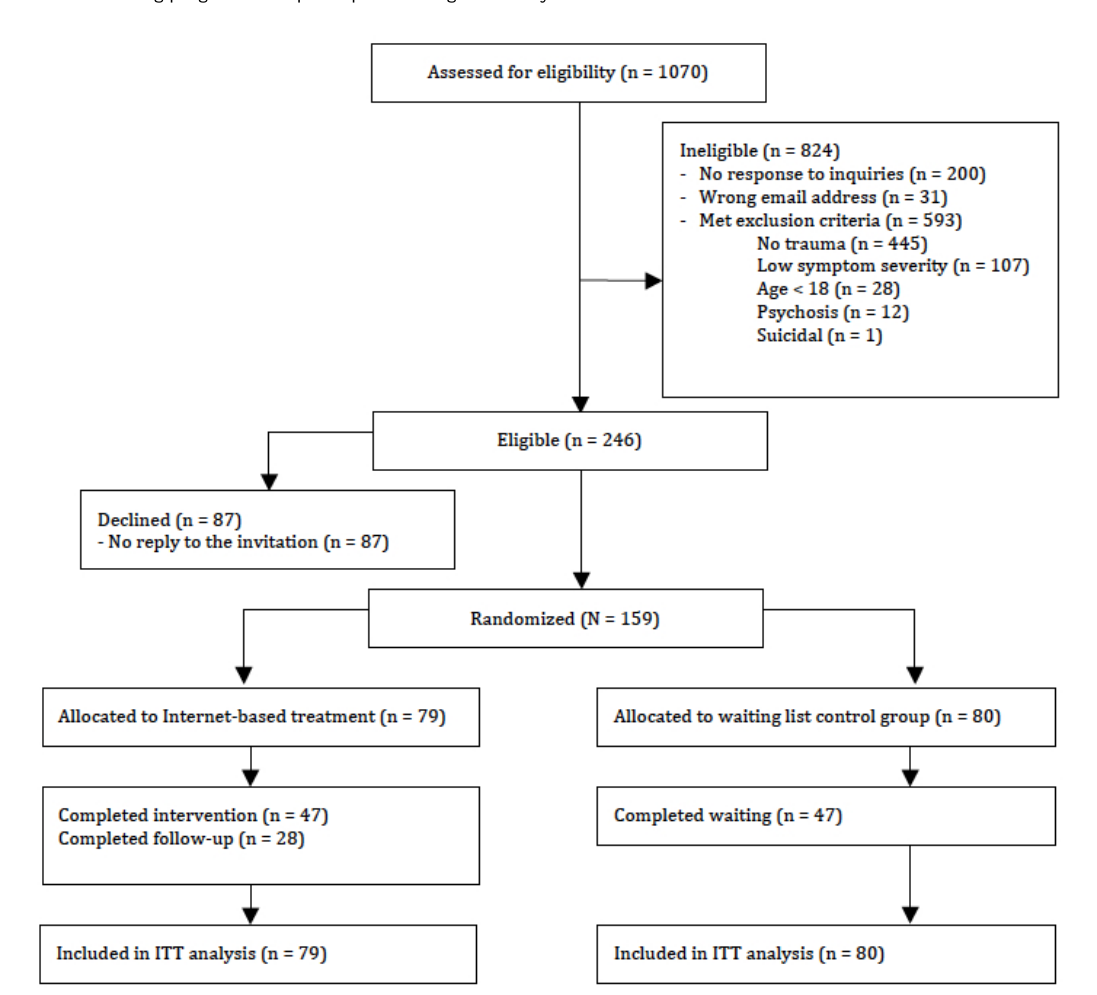
Figure 1. Flowchart showing progression of participants through the